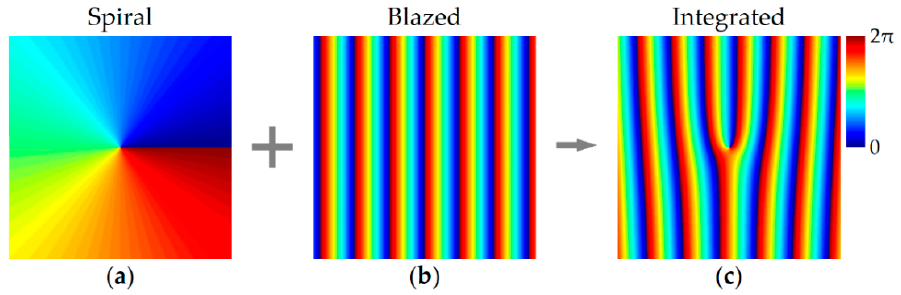
Figure 1. The calculated phase distribution of ( a ) a spiral phase; ( b ) a blazed phase; and ( c ) their integration with m = 1 and Λ ≈ 1.2 mm.